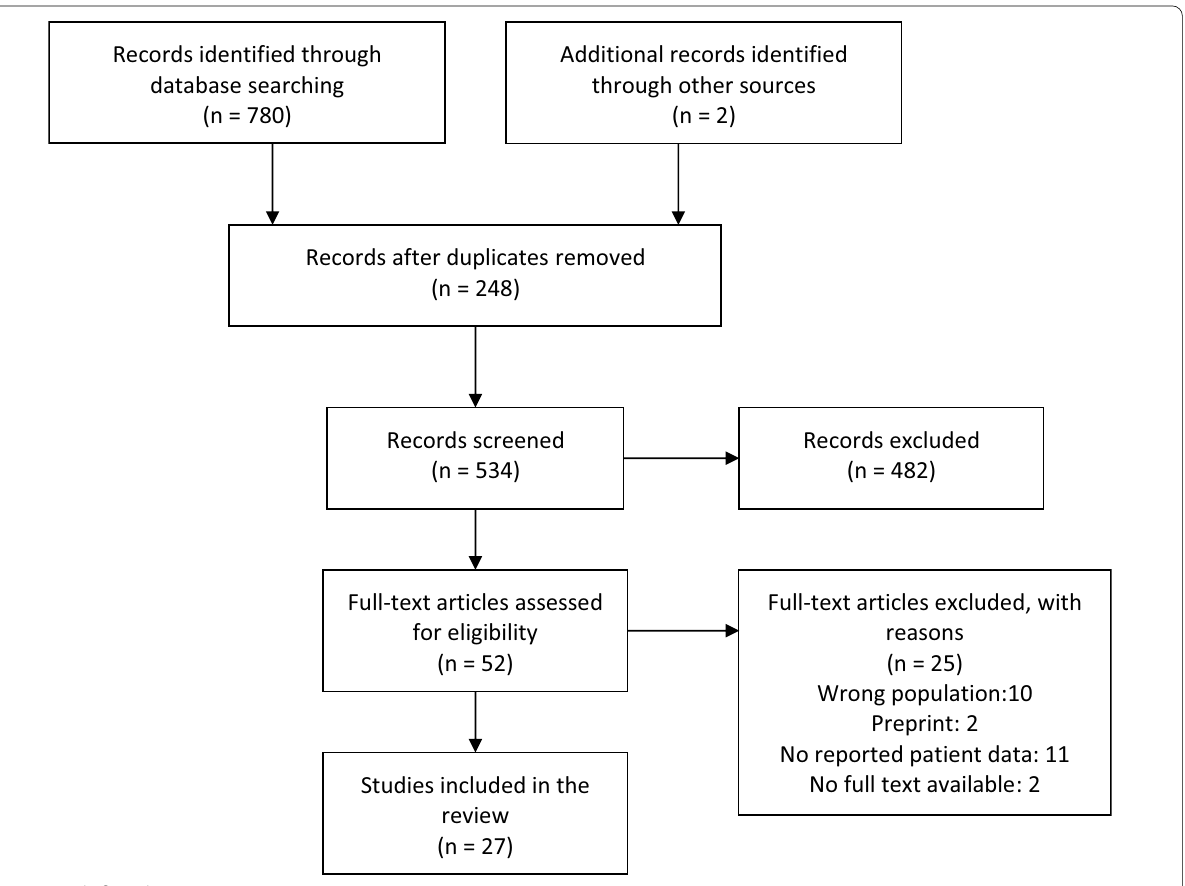
Fig. 1 Study flow